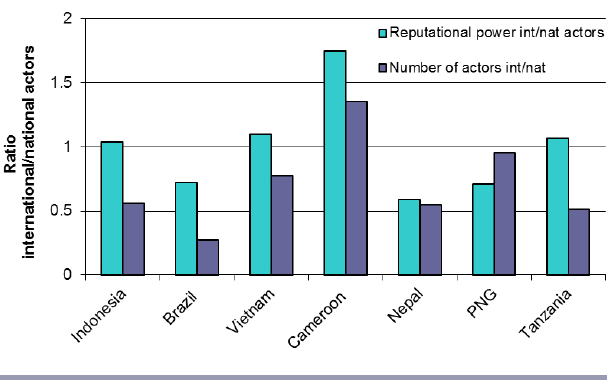
Fig. 3 . Relative presence and power of international and domestic policy